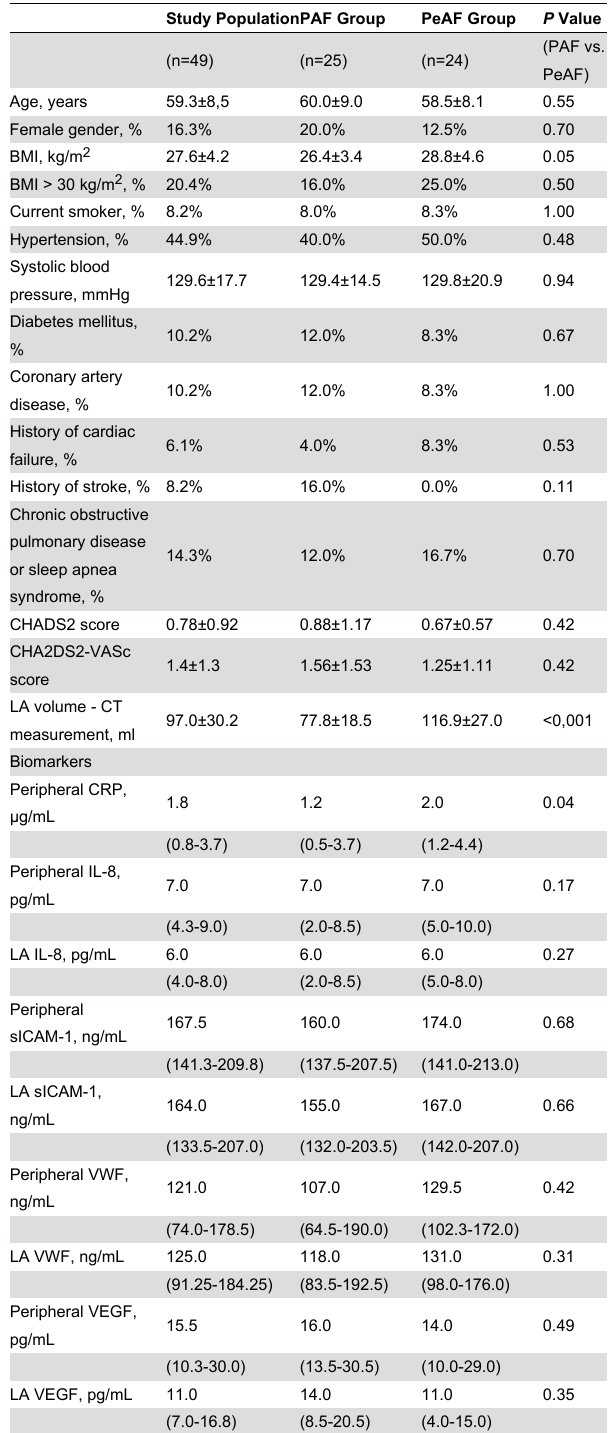
Table 1. Characteristics and Levels of Biomarkers in the Peripheral and Left Atrial Blood in the Study Population According to the Type of Atrial